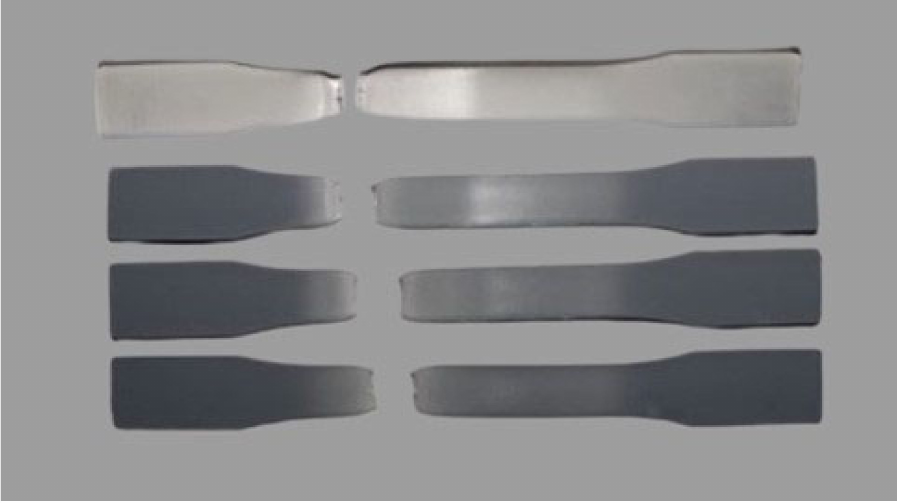
Figure 4. Optical images of all specimens after tensile test at room